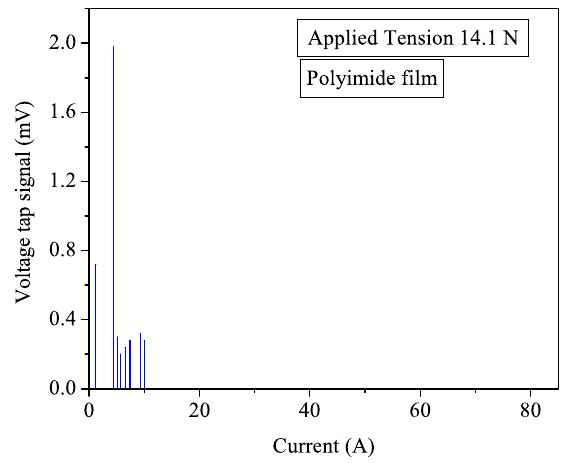
FIG. 2. (Color) Voltage tap signal as a function of current.